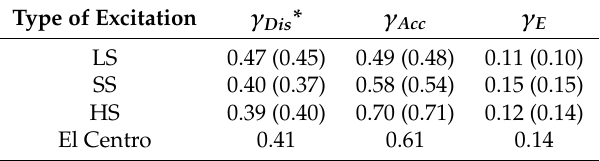
Table 1. Analysis results of γ Dis , γ Acc , and γ E for case in Section 4.2.